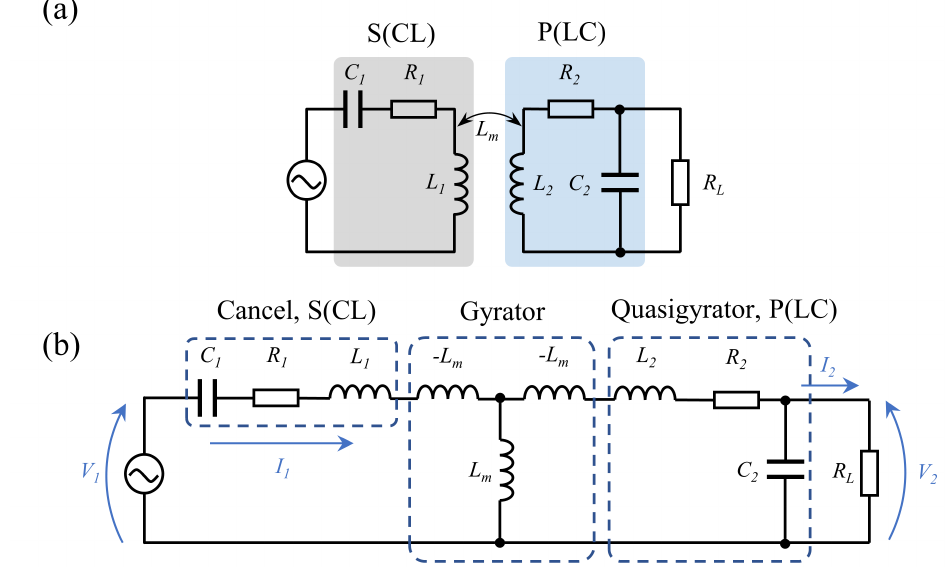
Figure 2. Circuit model of the S − P topology WPT system. ( a ) System structure of S − P topology WPT system, ( b ) equivalent circuit of S − P